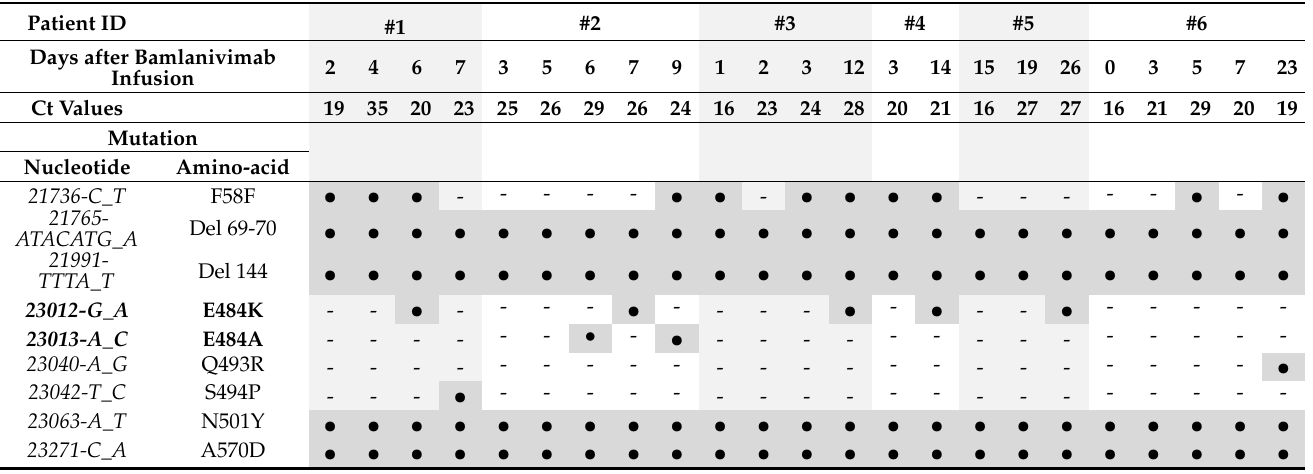
Table 1. Mutations observed on the S gene. Each mutation from the Wuhan reference genome is indicated by a “ • ”. Patient